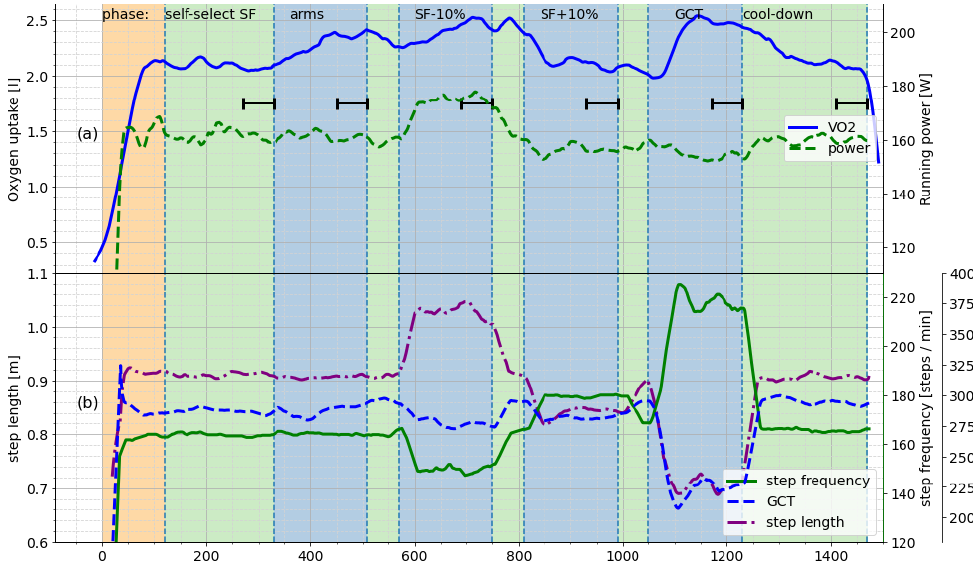
Figure 2. Exemplar protocol for the second part of the experiment and varying spatiotemporal parameters for a single subject. ( a ) Oxygen consumption ˙VO 2 and running power as measured using a single foot-worn commercial sensor during the running conditions. ( b ) Spatiotemporal running parameters of the subject in reaction to instructions for the experimental conditions. Reprinted with permission from Baumgartner et al. [11]. Best viewed in